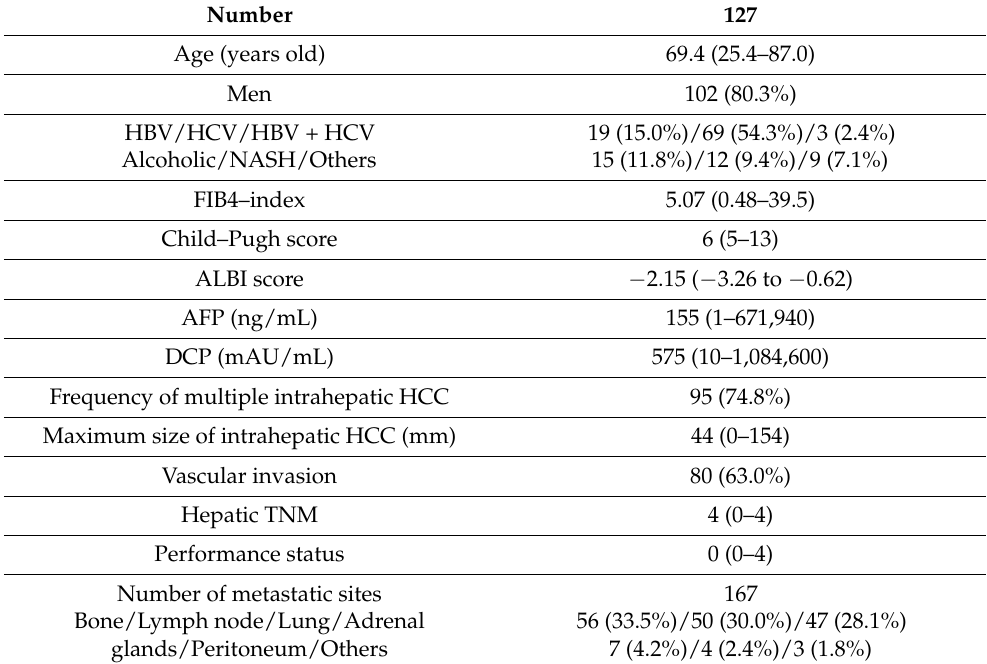
Table 1. Characteristics of patients with hepatocellular carcinoma upon diagnosis of metastases.